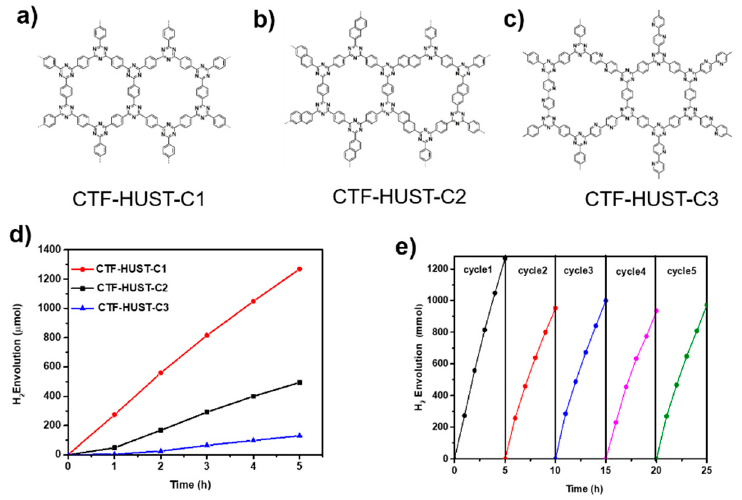
Figure 3. ( a – c ) Structure of highly crystalline CTFs obtained by the polycondensation method, ( d ) time course of photocatalytic hydrogen evolution and ( e ) recycle experiment of a CTF-HUST-C1 sample. (adapted from reference 79). Reprinted with permission from [79]. Copyright 2018, Wiley-VCH.